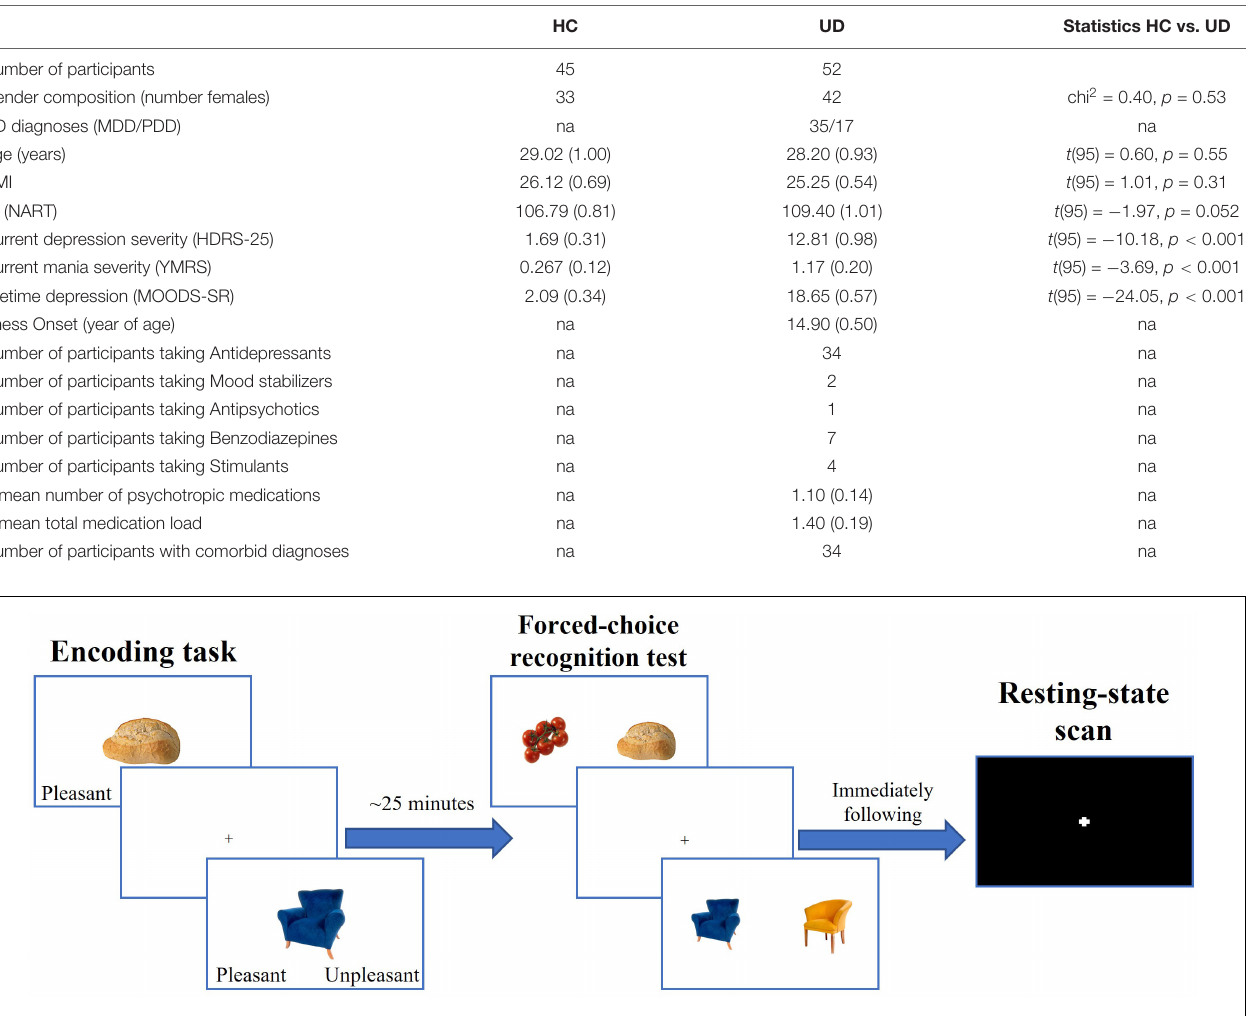
FIGURE 1 | Experimental